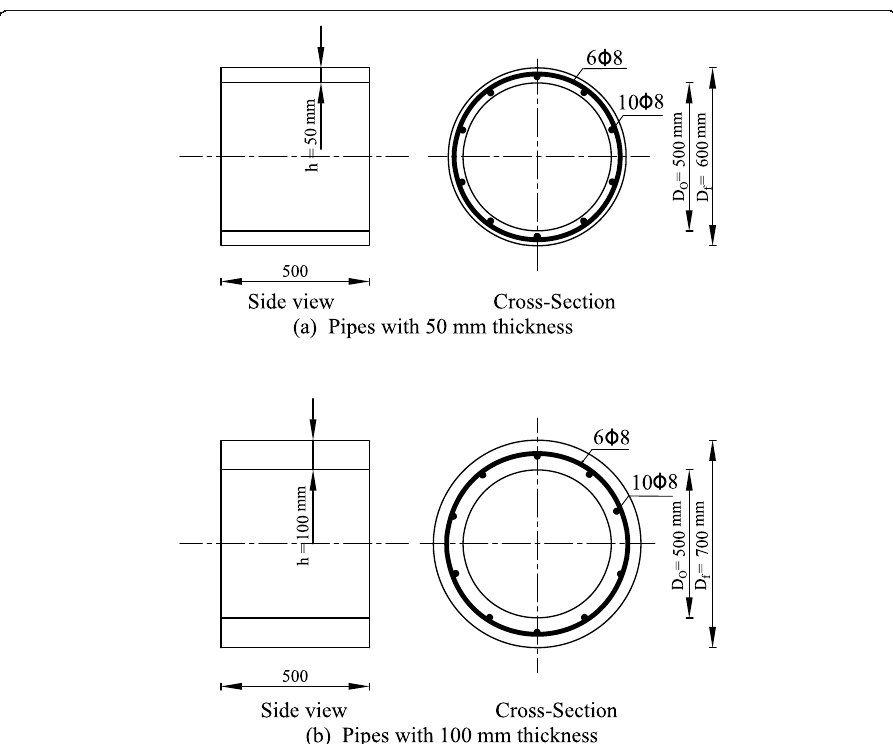
Fig. 2 Concrete dimensions and details of reinforcement of concrete pipes a pipes with thickness 50 mm b with thickness 100 mm (all dimensions are in mm)